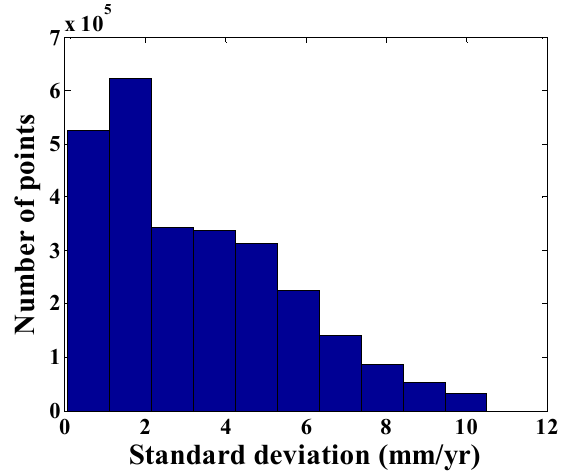
Figure 5. Distributions of standard deviations of subsidence rates.